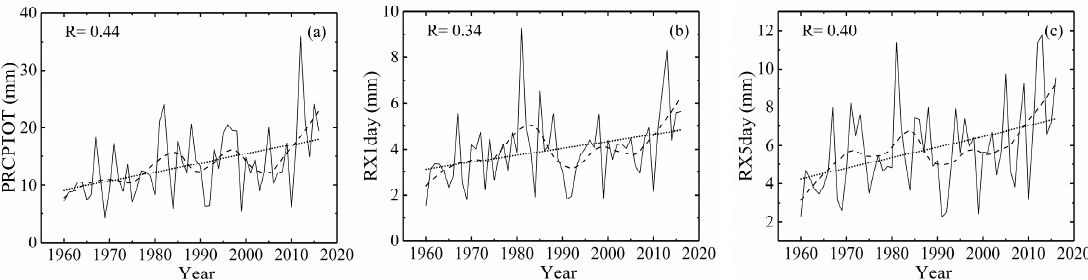
Figure 4. Regionally averaged series for the dry season for the indices of ( a ) PRCPTOT, ( b ) RX1day, and ( c ) RX5day over the SRYR during 1960–2016. The dotted line represents the linear trend and R is its correlation coefficient. The dashed line results from LOESS smoothing.